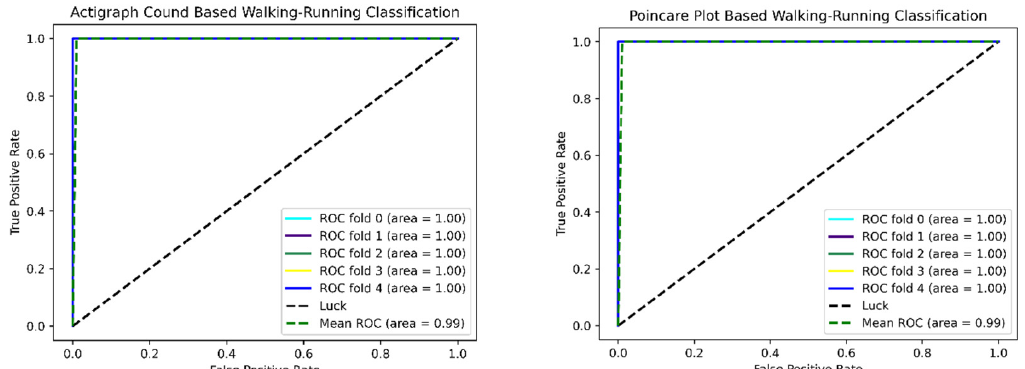
Figure 12. ROC curve for walking and running classification. The left panel denotes the ROC curve for the Actigraph count-based walking and running classification. The right panel denotes the Poincare plot-based walking and running activities’ classification.